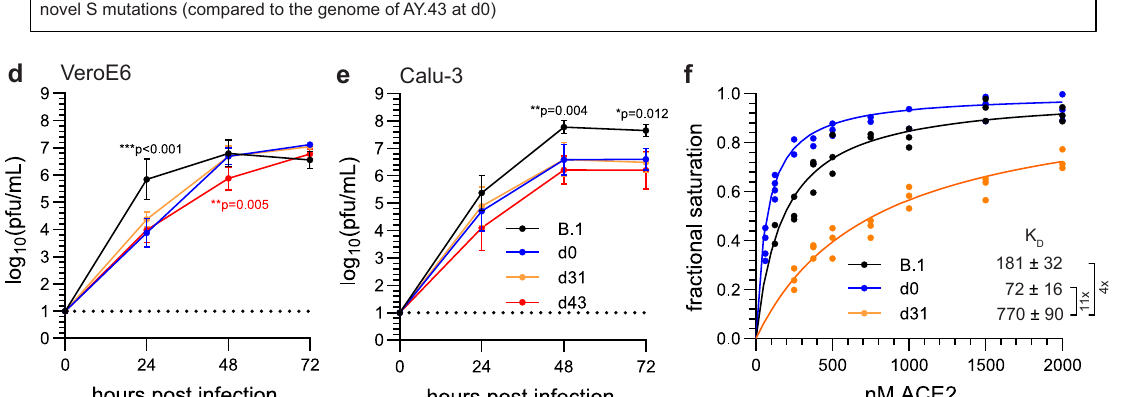
Indicated are the novel non-synonymous changes in the spike (S) gene acquired during viral persistence. d , e Growth of the three patient isolates in d VeroE6 and e Calu-3cells.ThecellswereeitherinfectedwithaprototypicB.1isolate(Muc-IMB- 1) or one of the patient isolates (d0, d31, d43) using a multiplicity of infection of 0.001. At 24, 48 and 72h post infection, cell culture supernatants were collected and viral titers were determined by plaque assay. The log-transformed titers are shown as means±SD of results from four independent experiments. Dotted lines indicate the assay cut-off. Signi fi cance was determined via two-way ANOVA with a Sidak´s multiple comparison test (* p <0.05, ** p <0.01). f Biolayer interferometry binding measurements of ACE-2 association with immobilized S showing variation of fractionalsignalsaturation for differentspike proteins. Thesolidline represents the best fi t calculated using Levenberg-Marquardt method. The dissociation con- stant K D was calculated from the fi tted line as well as from analysis of binding kinetics (Supplementary Fig. 2). Source data are provided in the Source Data fi le.